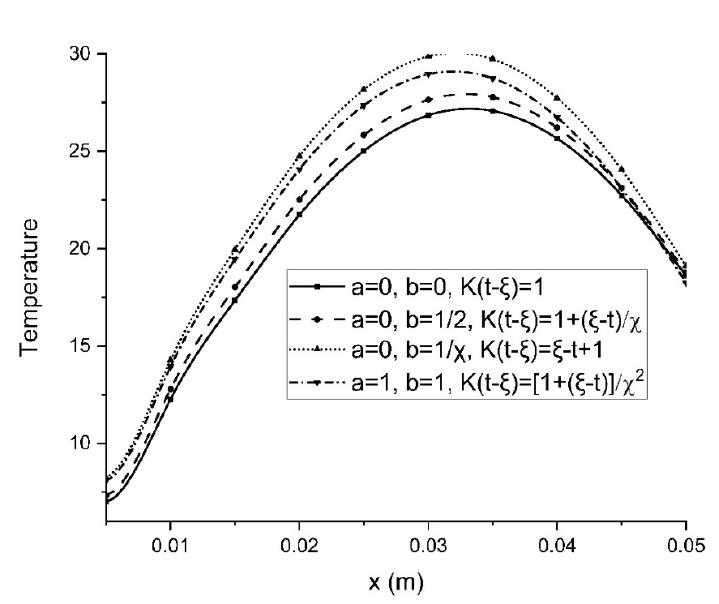
Figure 1. Temperature variations w.r.t. skin depth for different values of Figure 3 exhibits the variation of temperature along the kernel function K(t−ξ) = distance x by keeping the values of with different values time delay parameter for 𝜏𝜏 0 = 5 𝑠𝑠 𝑎𝑎𝑎𝑎𝑑𝑑 𝜏𝜏 𝑝𝑝 = 10 𝑠𝑠 𝜒𝜒